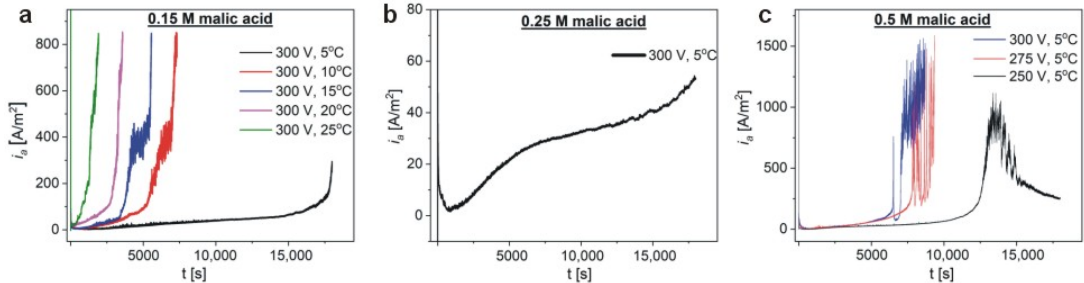
Figure 1. Current density ( i a ) versus time (t) transients for the samples anodized in 0.15 M ( a ), 0.25 M ( b ), and 0.5 M ( c ) malic acid solution.